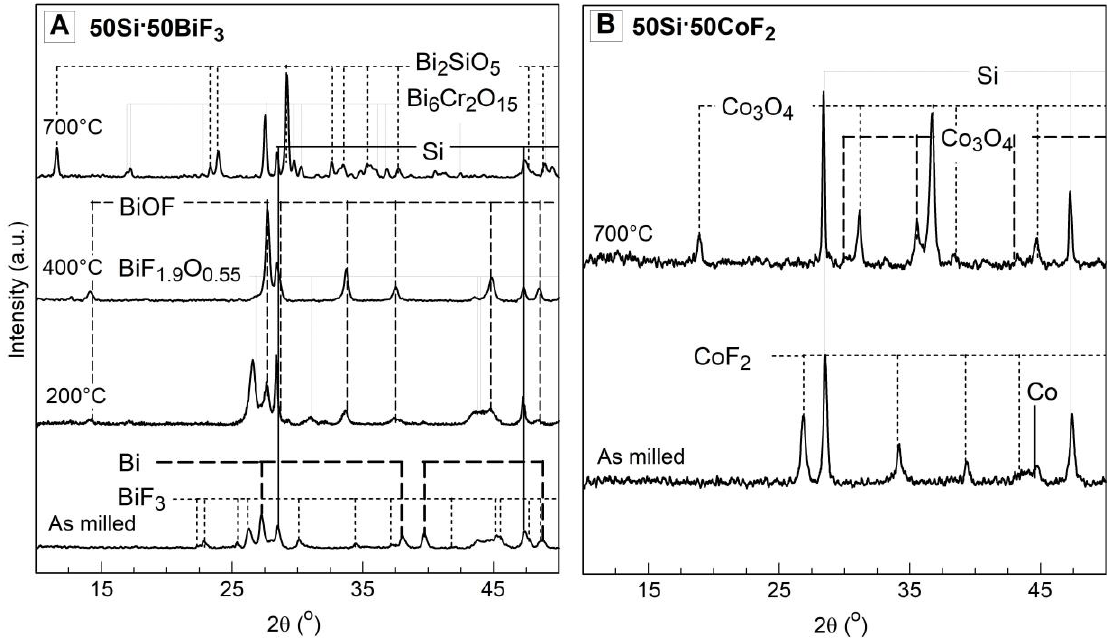
Figure 9. XRD patterns of the two-stage milled composites ( A ) 50Si · 50BiF 3 and ( B ) 50Si · 50CoF 2 heated at 5 K/min in Ar/O 2 and recovered from different temperatures.